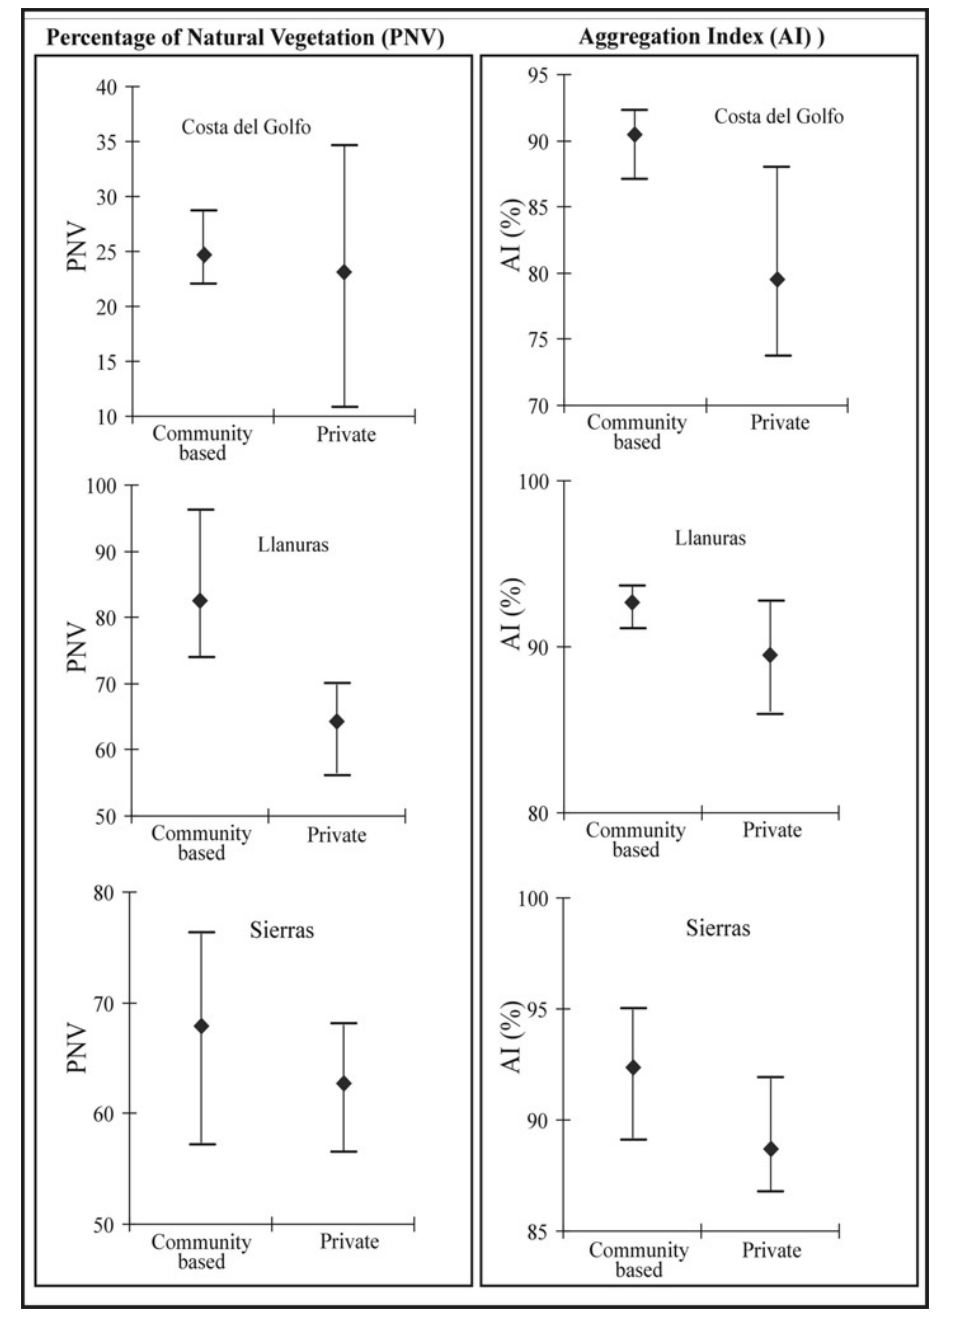
Fig. 4. Percentages of natural vegetation and mean aggregation index corresponding to community- based and private land ownership types at three physiographic provinces ( Costa del Golfo, Llanuras, and Sierras ). Mean values are shown by the diamond dots while dash lines represent minimum and maximum